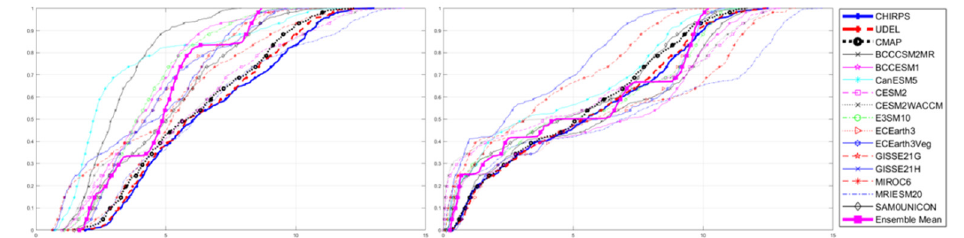
Figure 6. Cumulative distribution for northern Amazon (NAZ—( left ) panel) and southern Amazon (SAZ—( right ) panel) precipitation for 1981–2014 [mm day − 1 ].